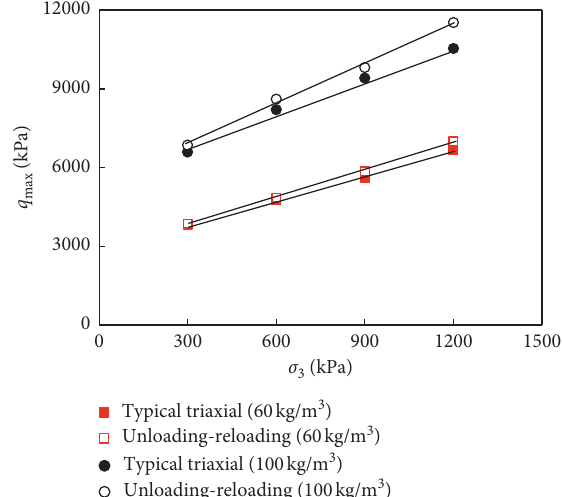
Figure 6: Relationship between shear strength q